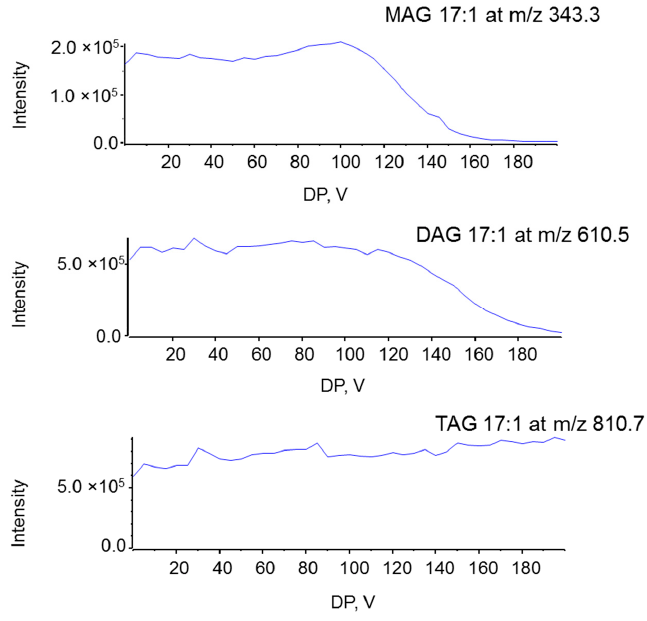
Figure 3. Effects of the declustering potential (DP) on ESI ionization of MAG 17:1, DAG d17:1, and TAG t17:1 at a concentration of 1 µM. Spectra were acquired under the following conditions: GS1 = 10, GS2 = 10, CUR = 15, Temp = 300 °C.